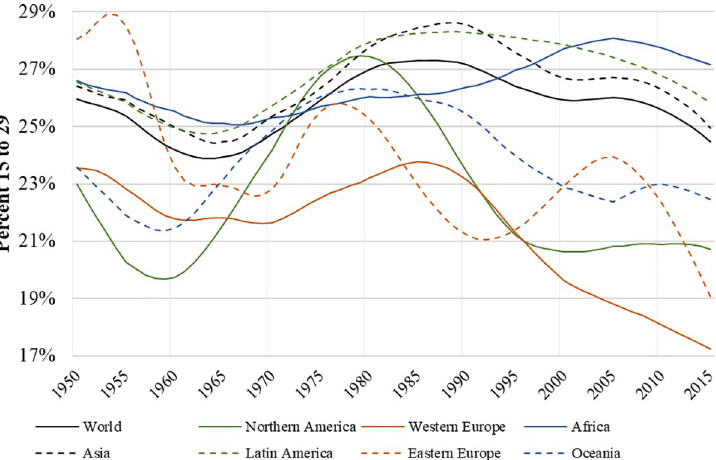
Fig 2. Percent of the population between 15 and 29 years by region and year– 1950 to 2015. Shown is the percentage of the population aged 15 to 29 for the entire world and across global regions from 1950 to 2015. Data are from the United Nations World Population Prospects: The 2017